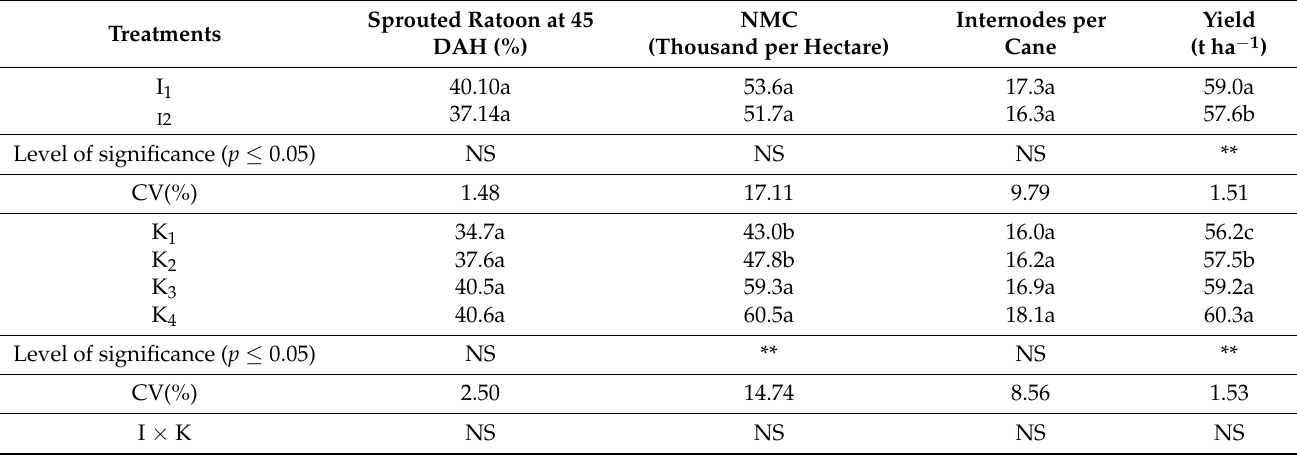
Table 2. Yield and yield parameters of sugarcane are influenced by different levels of irrigation and potassium.